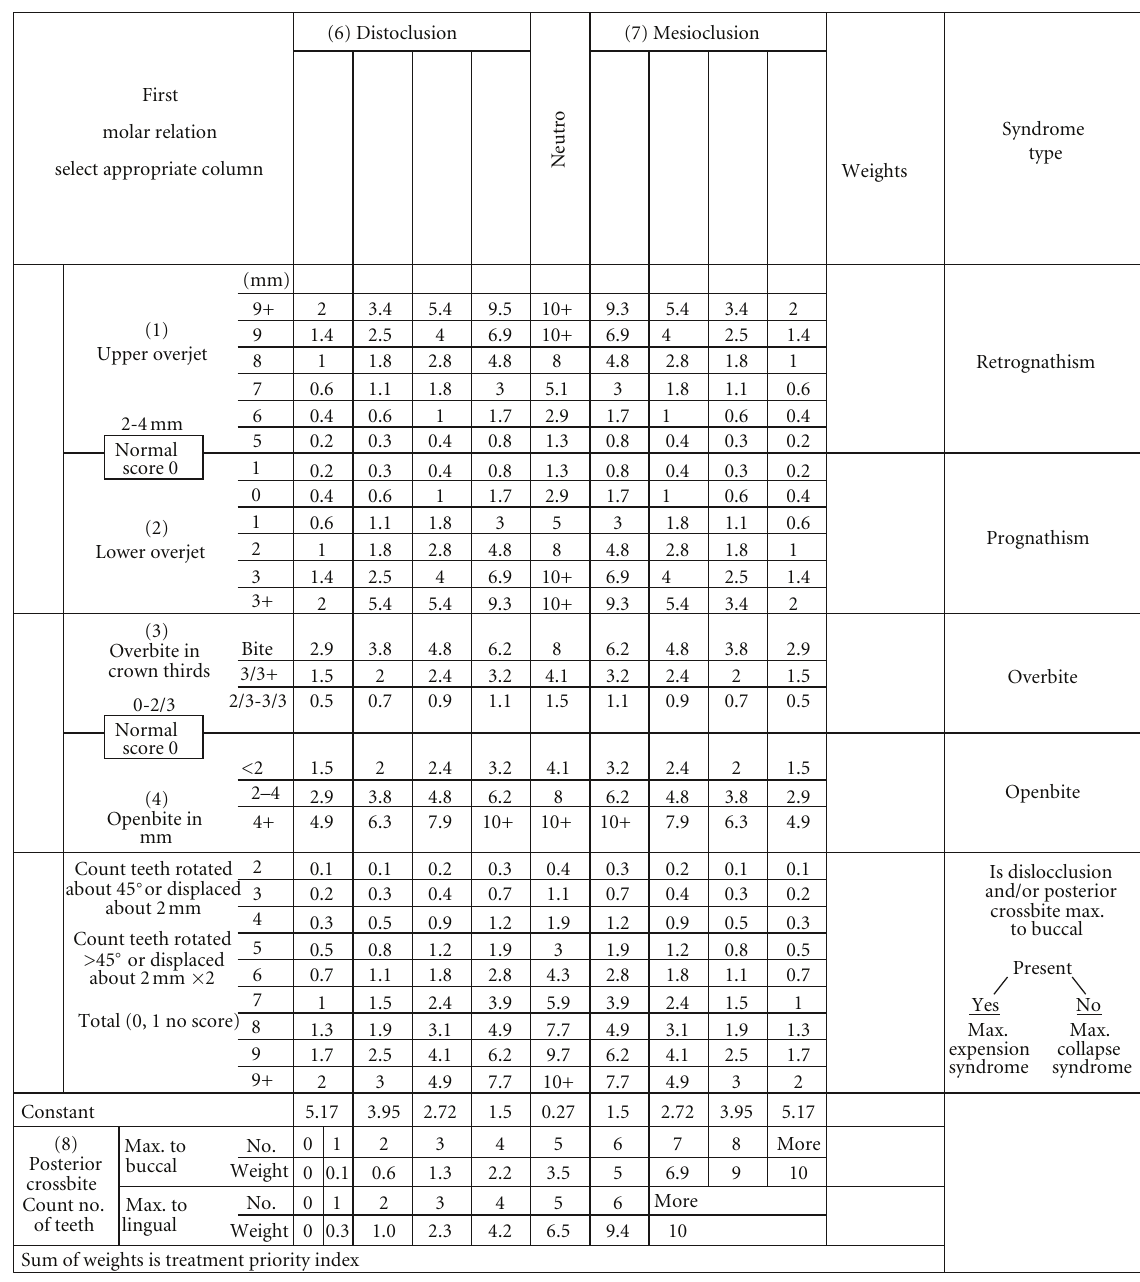
Figure 1: Treatment Index